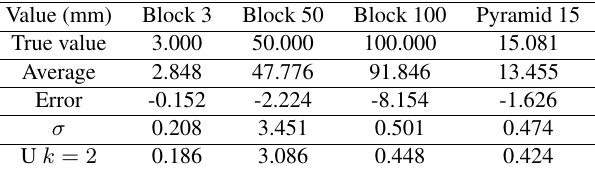
Table 2. Results of Passive Stereoscopy Technique.